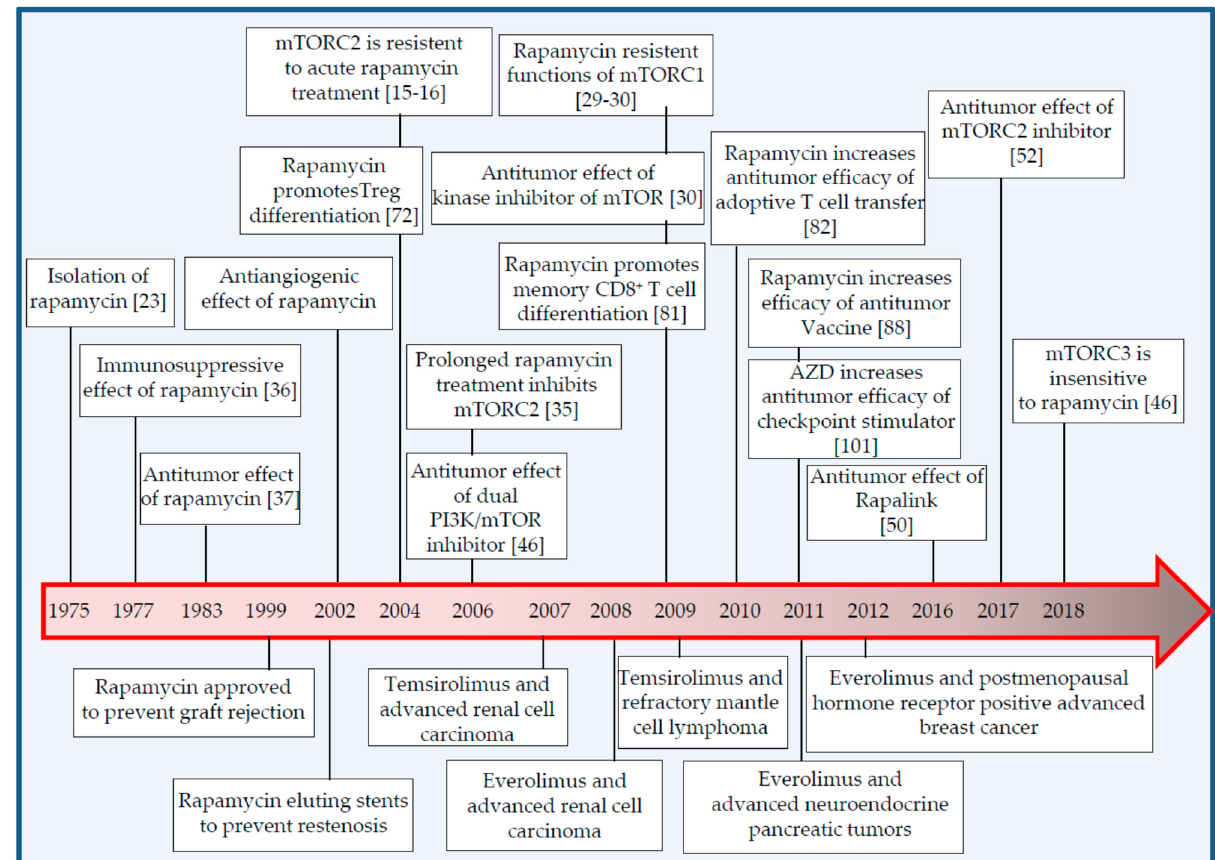
Figure 2. Milestones in development and therapeutic applications of mTOR inhibitors in the field of malignant cancers and immunity. Major therapeutic applications are described below the timeline. Corresponding studies are provided in square parentheses. Adapted from References [42,73].